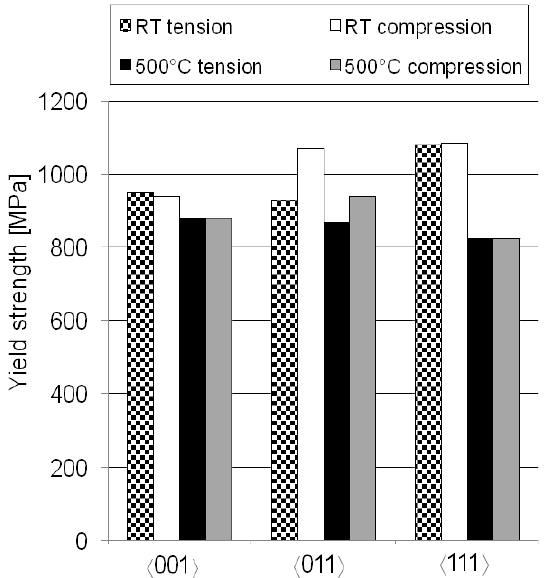
, and directions at RT and 500 °C. RT 〈 001 〉 〈 011 〉 〈 111 〉